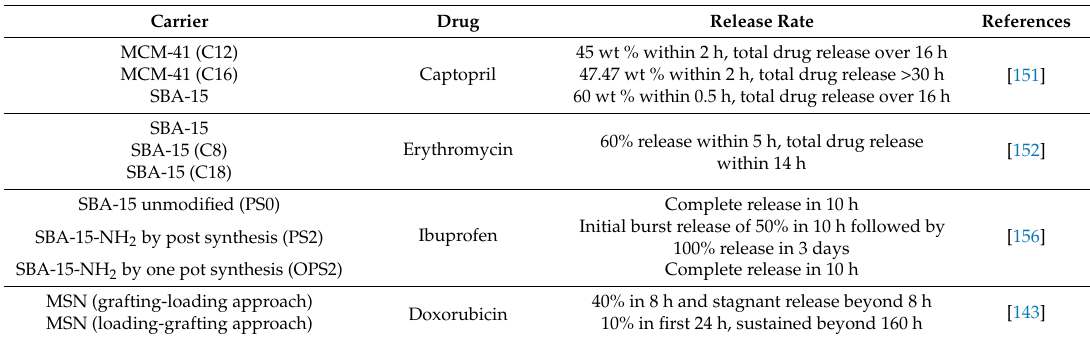
Table 5. Comparison of release rate of MSNs.